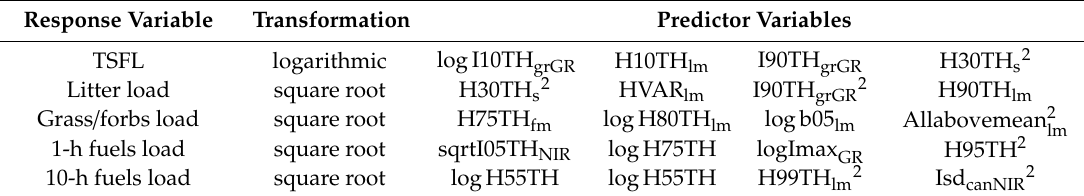
Table 7. Selected independent variables participating in the regression models for the estimation of the total and surface fuel types’ (SFT) load using LiDAR-derived height and intensity distribution descriptive statistics. The total surface fuel load (TSFL) includes the load of all SFTs sampled in each plot (i.e., litter, grass and forbs, shrubs, regeneration, 1-h, 10-h, and 100-h fuels). The definition of the independent variables’ names can be found in Table 3, while the lm, fm, s, gr, can su ffi ces refer to the last-of-many, first-of-many, single, single ground / near-surface (i.e., below 1m height), and single canopy returns (i.e., at or above 1 m height), respectively. The absence of these su ffi ces indicates that the respective metric was calculated for the entire point cloud. GR and NIR su ffi ces are included only in the intensity metrics of single returns (only single returns were range normalized) and refer to the Green and Near-Infrared channels. The predictor variables are presented with transformations (logarithmic-log, square root–sqrt and square), as employed in each model.